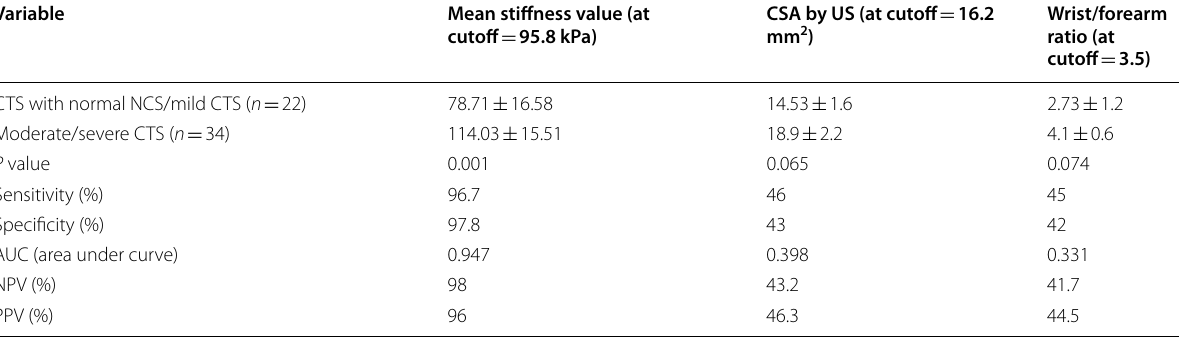
CTS carpal tunnel syndrome, kPa kilopascals, NCS nerve conduction studies